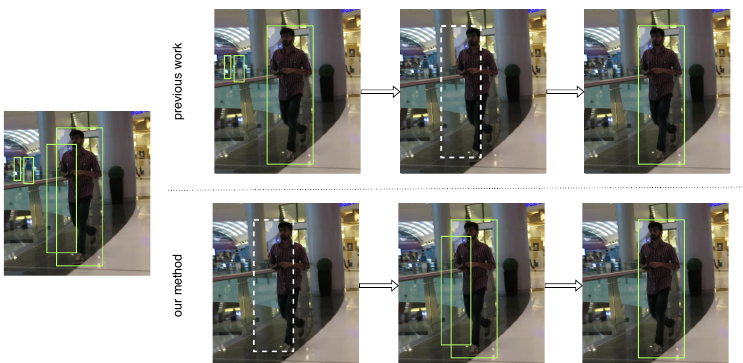
Figure 2. Workflow of NMS performing in tracking and previous work: The first column of pictures on the left is the detection result a without NMS performed. The first row of pictures on the right is previous work, the first column of pictures is the gt boxes after performing NMS on a , the white box of the second column of pictures is the target position predicted by Kalman filtering, and the third column of pictures is the result of IOU calculation of gt boxes and predictions. The second row of pictures is our method, the first column of pictures is the target position predicted by Kalman filtering, and the second column of pictures is the result of the detection result and the predicted NMS according to the IOU. The third column of pictures is the result of further taking the box with higher confidence as the prediction